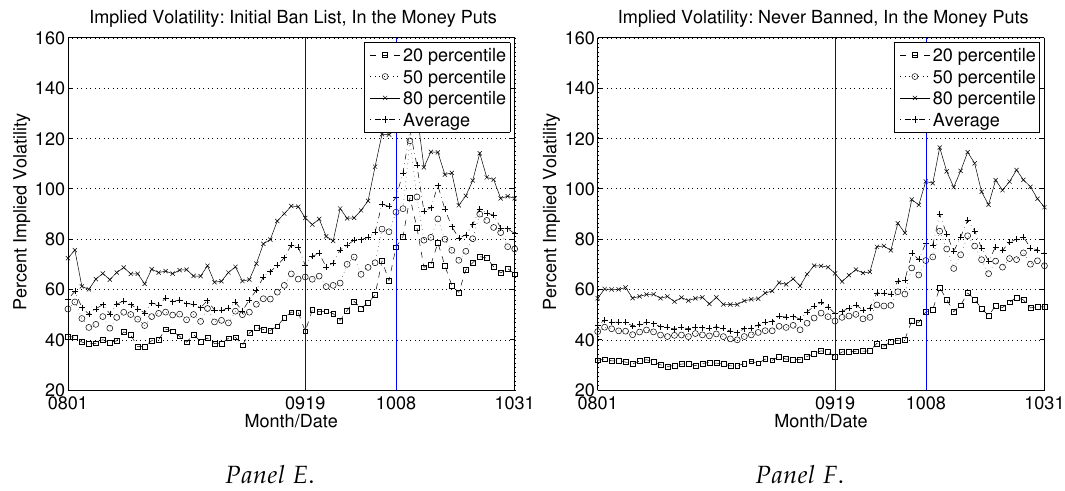
Figure 8. Time series of cross sectional options summary statistics: In the money put options of Initial Ban List and Never Banned Stocks during the ban and non-ban periods: ( A , C , E ) results for the three variables for Initial Ban List Stocks; and ( B , D , F ) results for the three variables for Never Banned